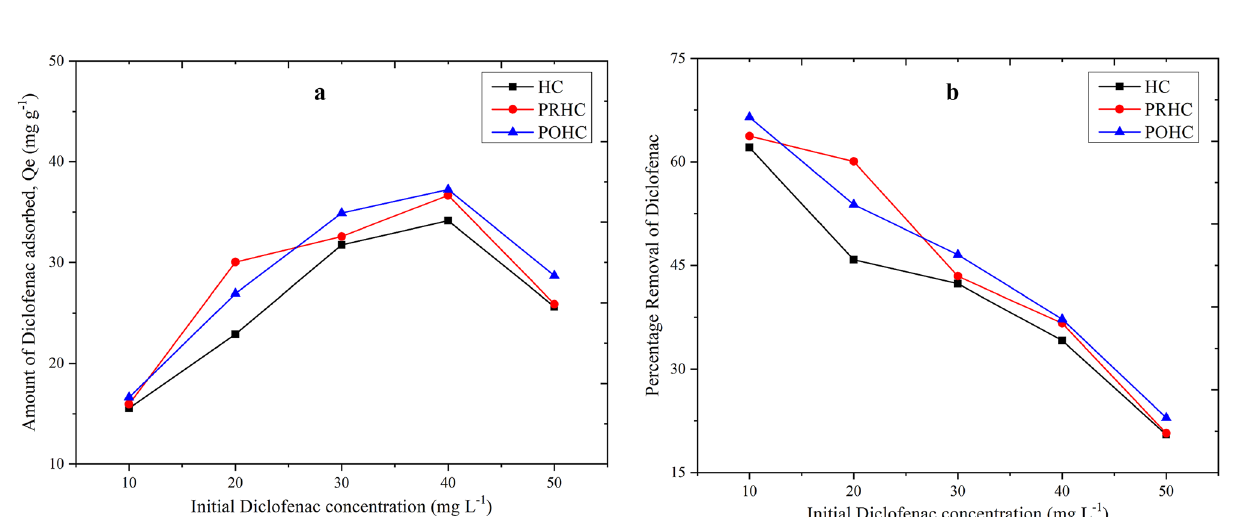
Figure 9. Diclofenac removal at equilibrium